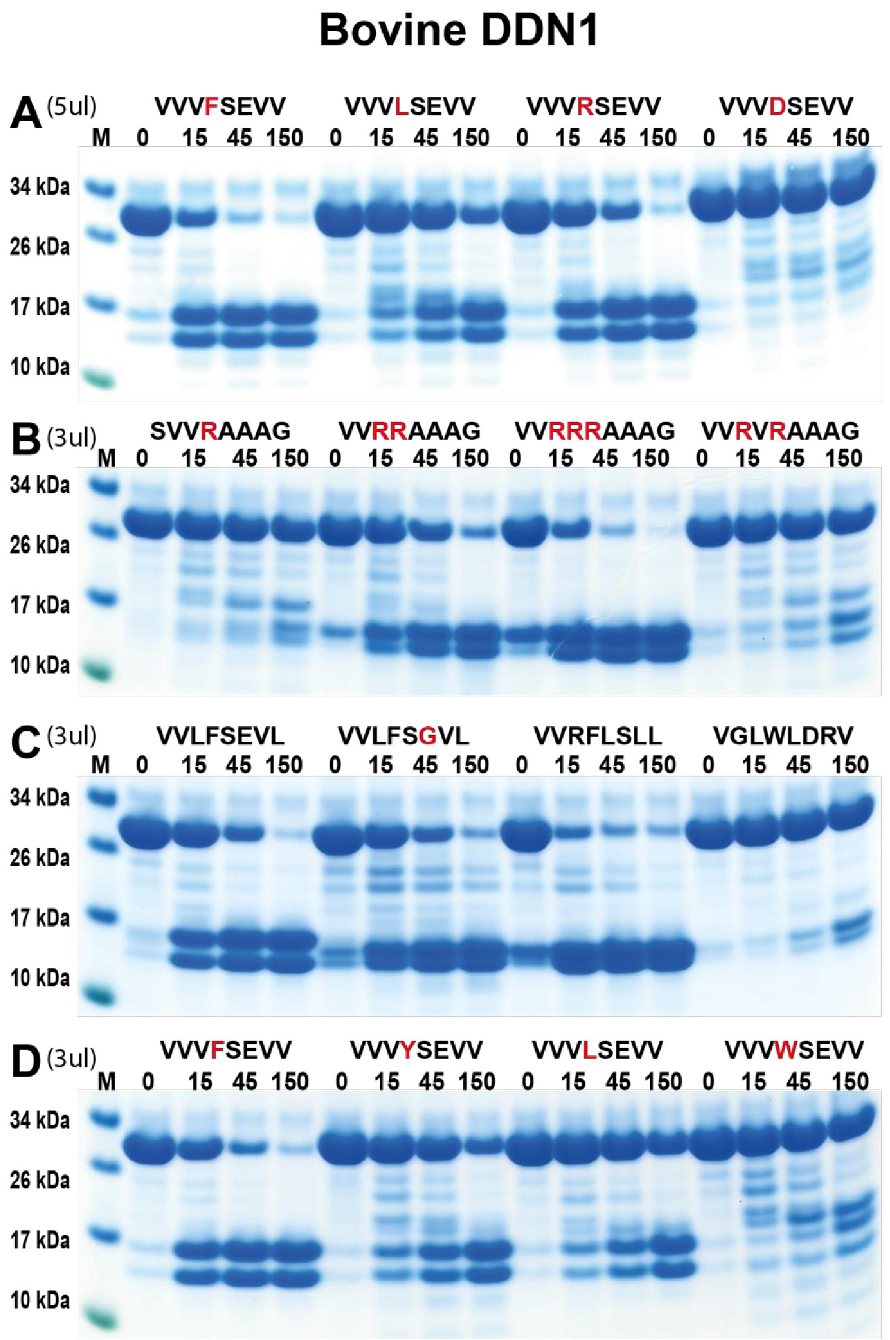
Fig 11. Analysis of the cleavage specificity of bovine duodenase DDN1 using recombinant protein substrates. Panels A to D shows the cleavage of several substrates by the bovine DDN1. The sequence of the different substrates are indicated above the pictures of the gels. The time of cleavage in minutes is also indicated above the corresponding lanes of the different gels. The uncleaved substrates have a molecular weight of ~25 kDa and the cleaved substrates appear as two closely located bands with a size of 12–13 kDa. Residues of particular interest and that may differ between different substrates are marked in red or green for an easy identification.